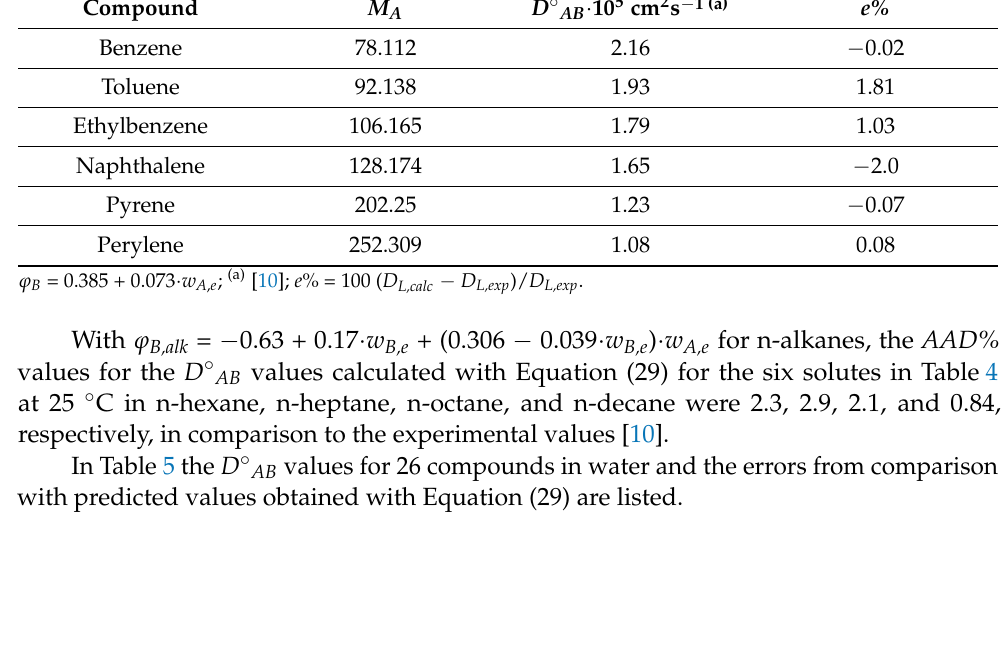
Table 4. Comparison of the D ◦ AB -values for compounds with the relative molecular mass M A , calculated with Equation (29) with experimental data from [10]. Solvent n-decane, M B = 142 at 25 ◦